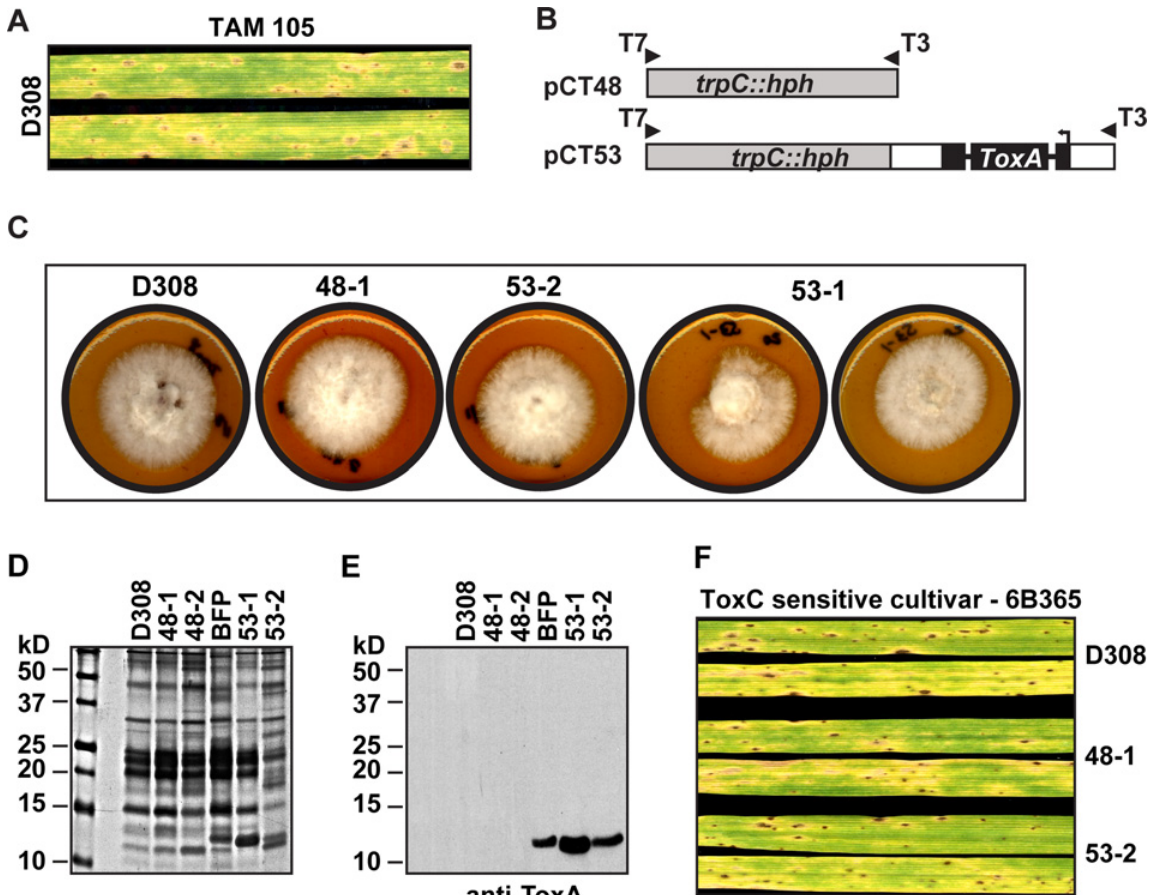
Fig 5. Characterization of growth and toxin production in D308 and D308- ToxA + isolates. (A) Inoculation of ‘ TAM 105 ’ with a race 3, ToxC-producing isolate, D308. (B) Constructs used as templates for PCR amplification with T3 and T7 primers for DNA fragment generation for genetic transformation of D308. Plasmid constructs were originally described in [12]. (C) Colonial morphology of isolates grown for 6 days on V8-PDA agar. Note the abnormal morphology of 53 – 1. SDS-PAGE of equal amounts of protein from crude culture filtrate either (D) silver-stained or (E) on western blot with anti-ToxA antisera. The molecular mass of standards and their position are indicated on the left of each gel. (F) Inoculation of isolates on the ToxC-sensitive cultivar ‘ 6B365 ’ . Leaves were harvested 6 days post